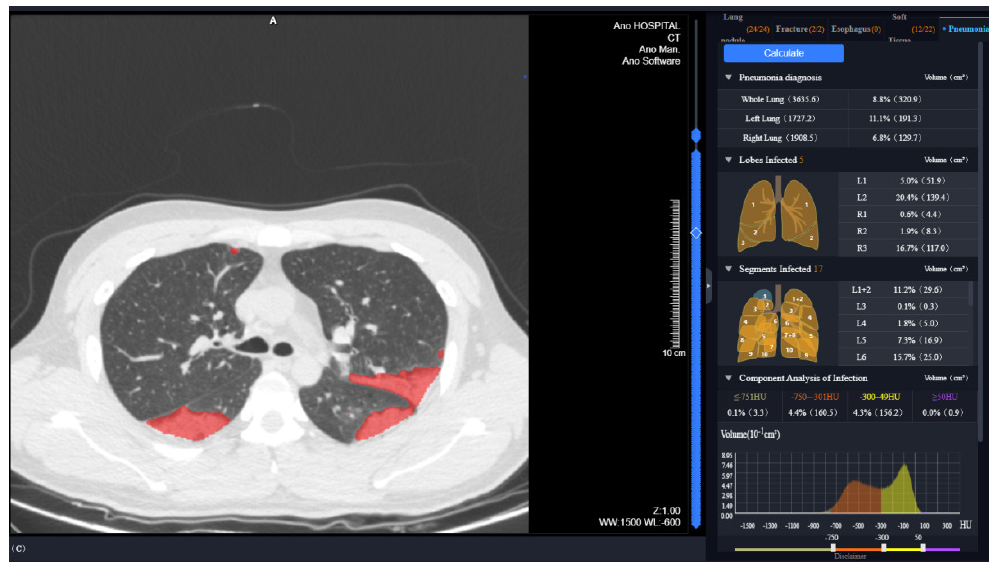
Figure 1. Quantitative analysis of CT images at discharge in uAI intelligent assistant system.